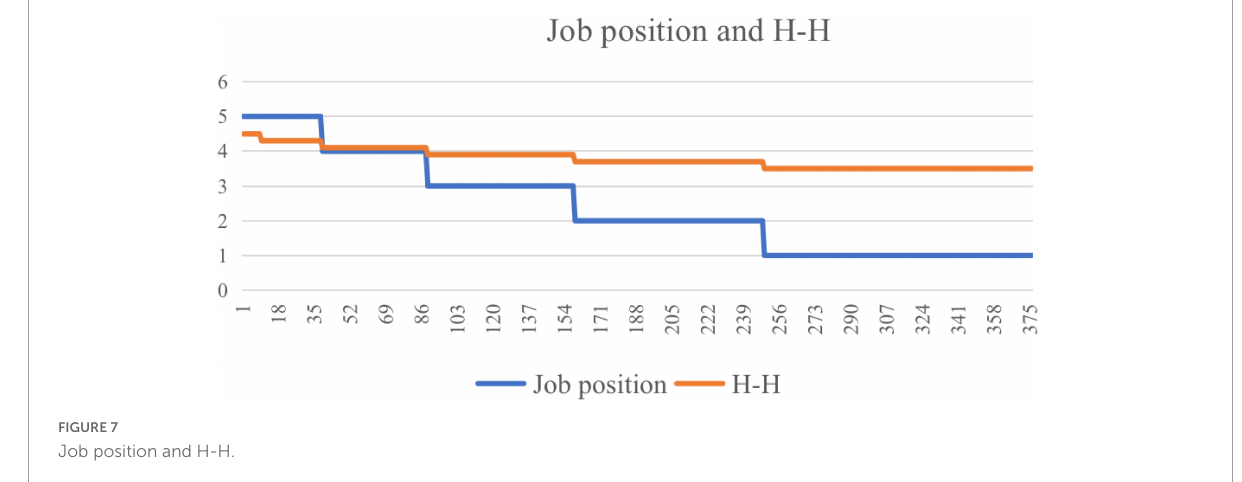
FIGURE7 Job position and H-H.